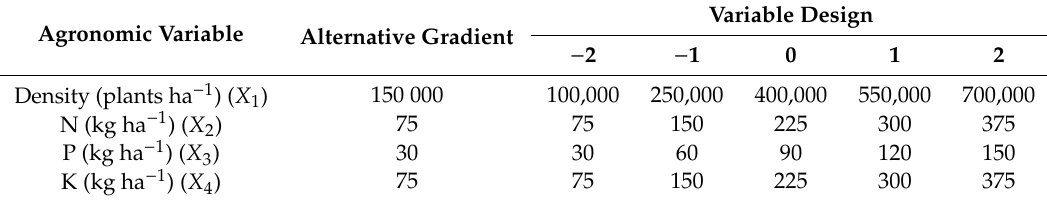
Table 1. Central composite design of plant density and fertilizer